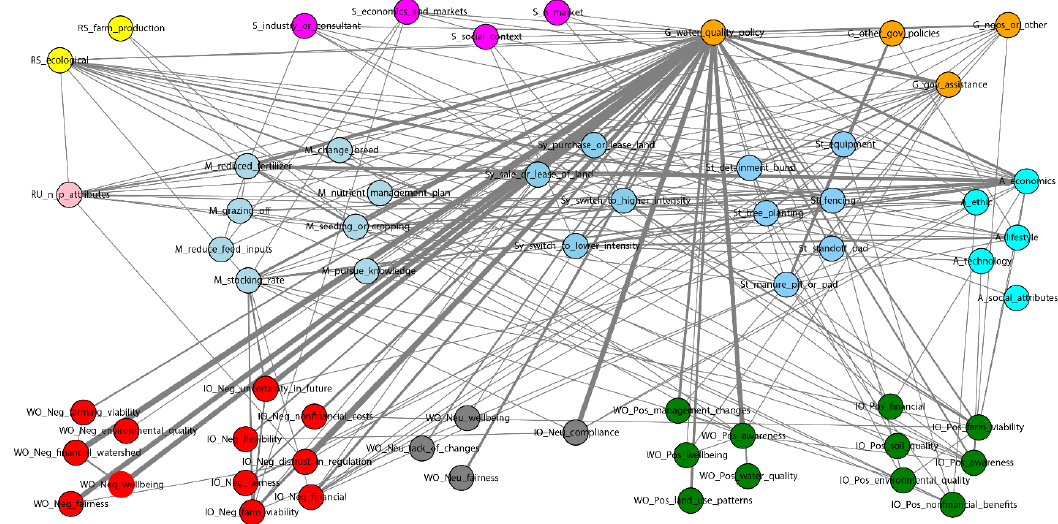
Figure A1.4. Rotorua SES sub-category group mental model